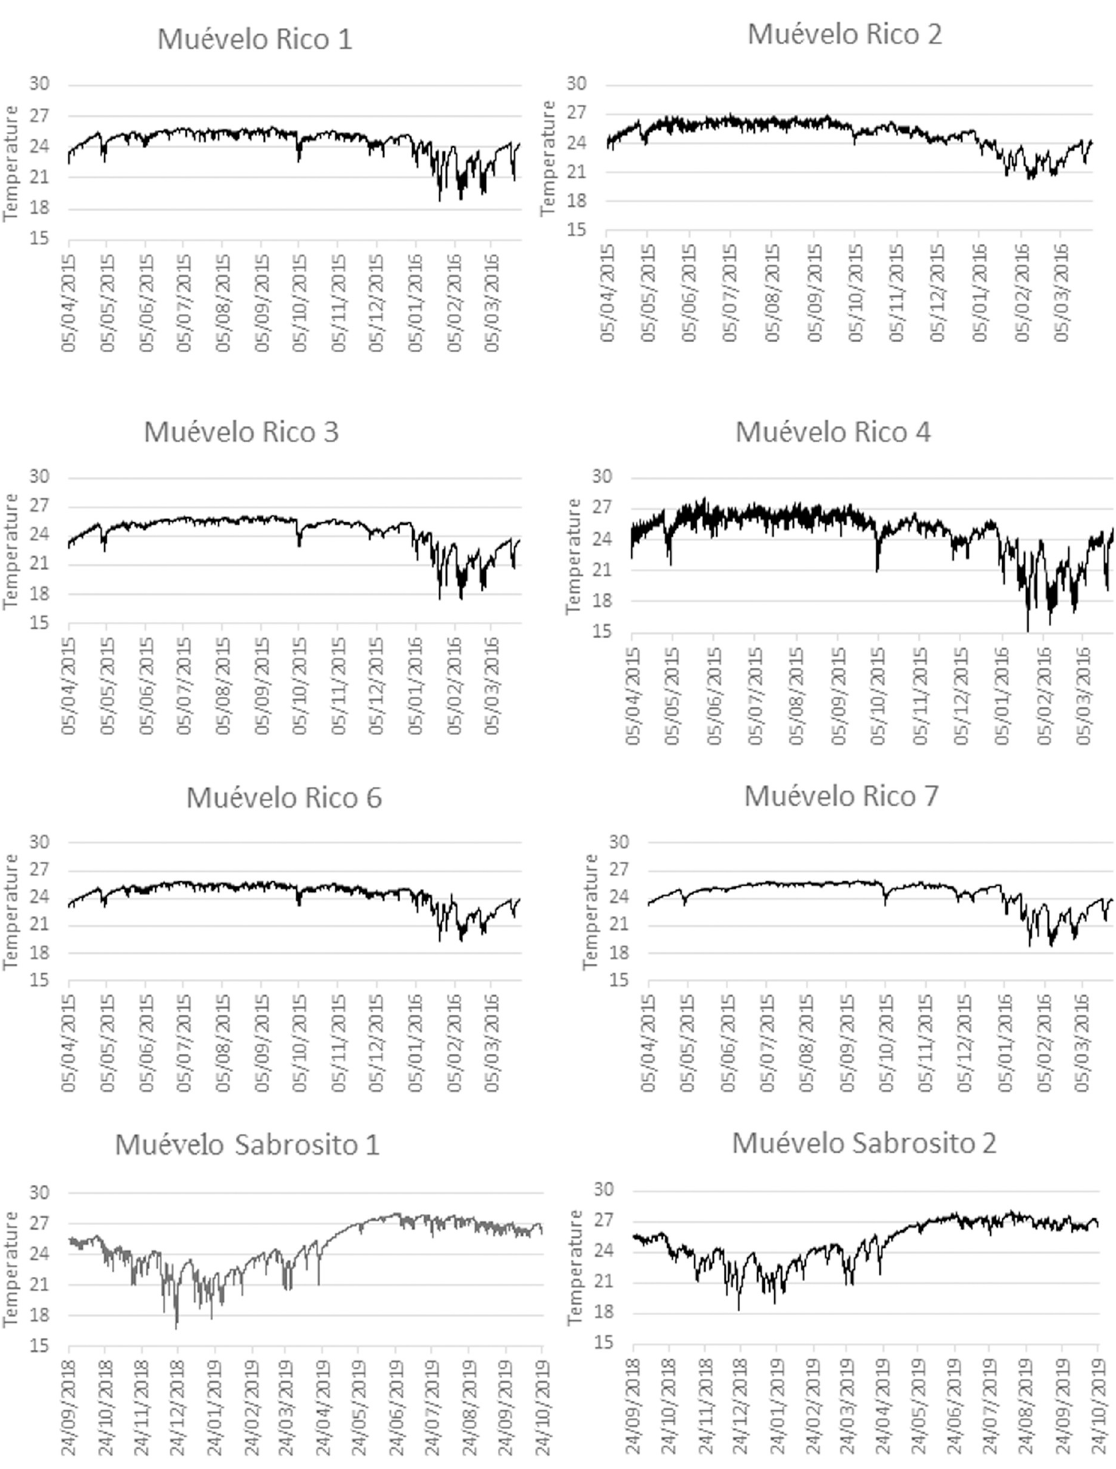
Fig 3. Plot of hourly temperature at stations in Sistema Mue´velo Rico and Mue´velo Sabrosito. Each station is plotted separately, showing all hourly data. Note that the minimums and higher variability all occur in winter. The patterns appear to be different because of the dates of measurement in the two